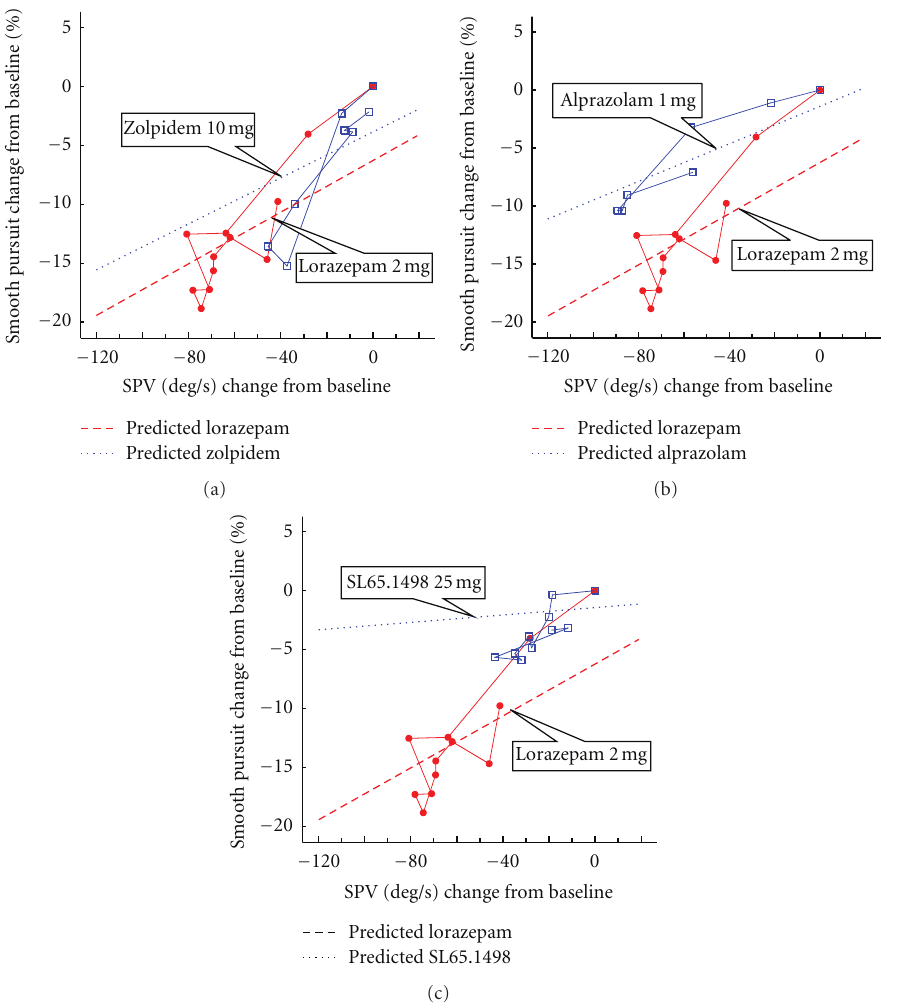
Figure 3: Δ Smooth- Δ SPV relative e ff ect profile of SL65.1498 25mg, zolpidem 10mg, and alprazolam 1mg versus lorazepam 2mg, respectively. (Blue open square: investigational compound; red closed circle: lorazepam 2mg; blue dot line: the comparator drug, red dash line; lorazepam